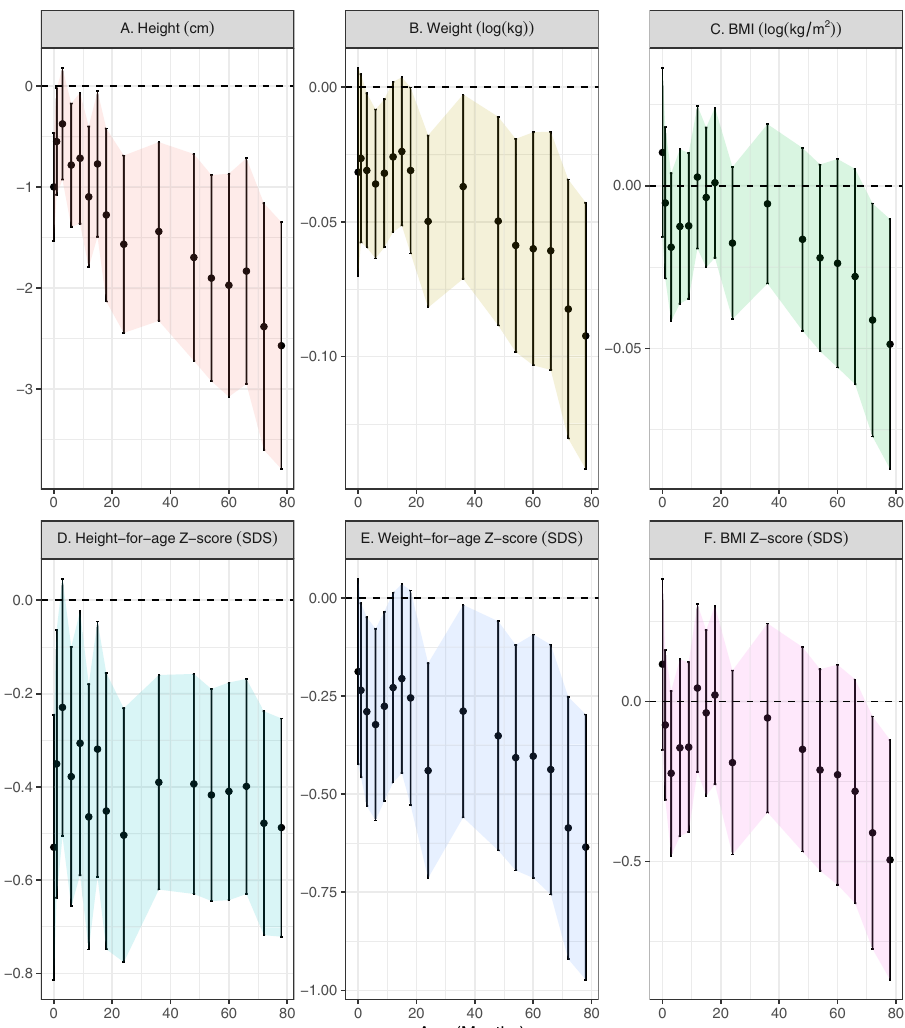
Fig. 1 Associations between ART status and anthropometry, adjusted for pre-pregnancy characteristics. Point estimates and Wald-type 95% con fi dence intervals show the adjusted mean difference in anthropometric measures between ART-conceived and spontaneously conceived (SC) children at each study visit, with SC children as the referent. Differences were estimated by multivariable linear regressions adjusted for maternal age, education, ethnicity, household income, height, pre-pregnancy BMI, parity, and any tobacco exposure in the home; paternal age, height, weight, diabetes history, and high blood pressure history; child sex, and polygenic risk score for adult adiposity with no multiple testing adjustments. Multiple imputations by chained equations were used to estimate associations while simultaneously accounting for missing covariate values. Sample sizes at each visit (SC/ART): 1091/83; 967/69; 953/71; 916/68; 872/70; 892/68; 874/67; 807/55; 832/60; 864/64; 801/57; 833/64; 812/61; 800/63; 771/59; 762/59. Shaded regions connect con fi dence intervals to aid in visualizing trends and provide no additional information regarding estimates between visits. cm centimeters, kg kilograms, SDS standard deviation